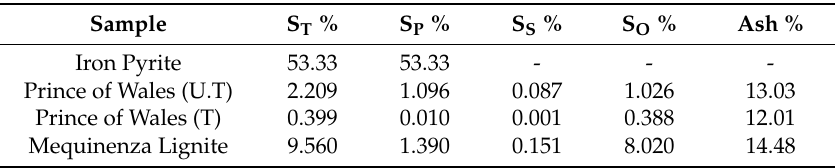
Table 8. Sulphur Analysis of the Samples for TPI